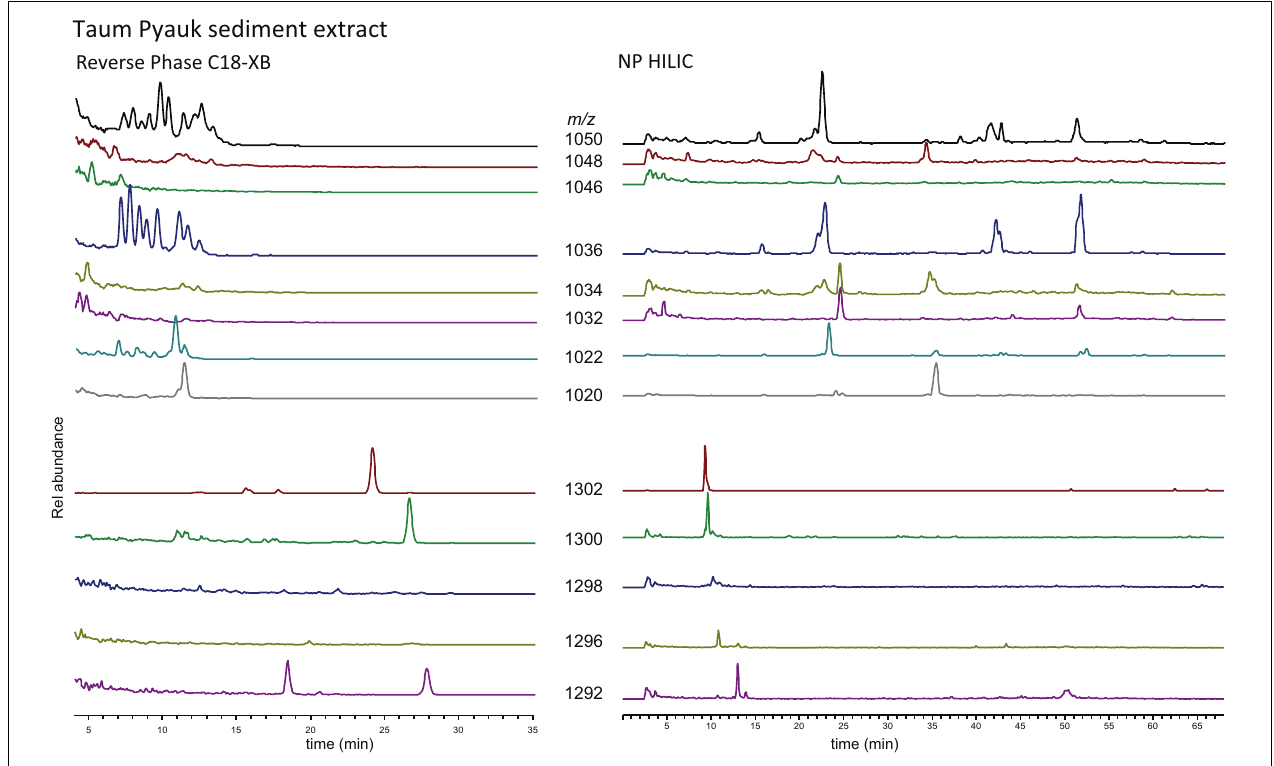
FIGURE 8 | C18-XB (left) and HILIC (right) selected ion chromatograms of branched and isoprenoid GDGTs from Taum Pyauk soda lake, Myanmar. In RP, many isomers can be observed for the branched GDGTs, while these are not clearly visible in NP. The m / z 1292 trace shows a clear isomer after the main peak at 13 min in the HILIC run. In RP, m / z 1292 exhibits two clear, nearly equally sized peaks.